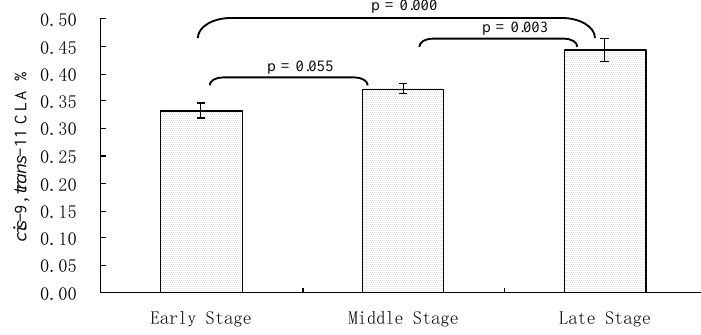
Figure 1. cis- 9, trans- 11 CLA content in milk from dairy cows at different lactation stages (Experiment 1).